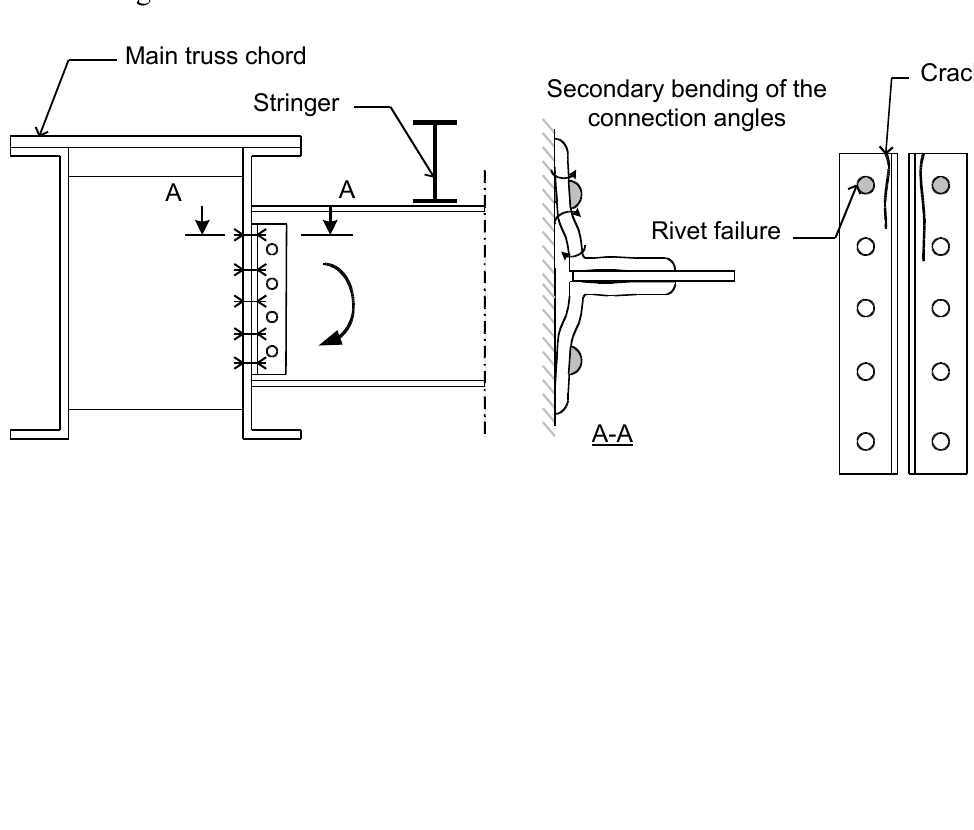
Figure 17. Fatigue damage in a floor beam riveted to the main truss connection as a result of the restraining